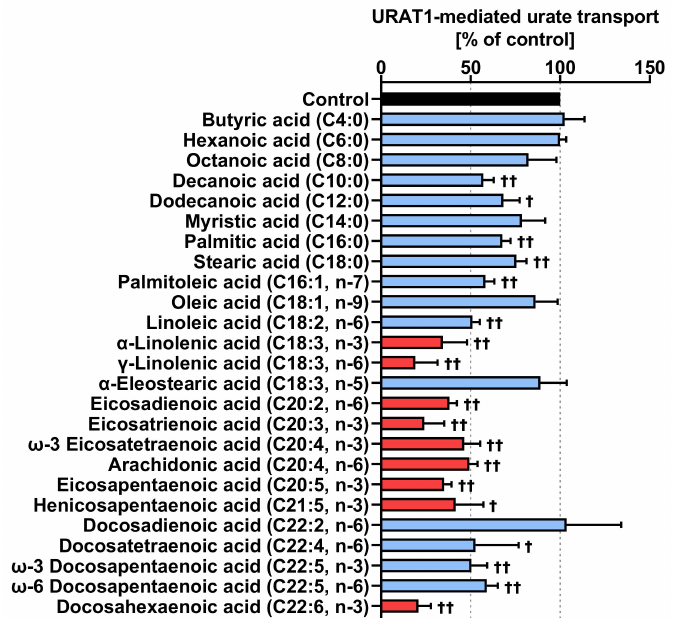
Figure 2. Inhibitory e ff ects of each fatty acid on URAT1-mediated urate transport. The e ff ects of each fatty acid (100 µ M) on URAT1-mediated urate transport were investigated with the urate uptake assay. Control, vehicle (non-fatty acid treated) control. Data are expressed as the mean ± SD; n = 3–4. † , p < 0.05; †† , p < 0.01 vs. control (one-sample t -test). Red bars mean that the tested fatty acids inhibited URAT1-mediated urate transporter activity by over 50% compared to